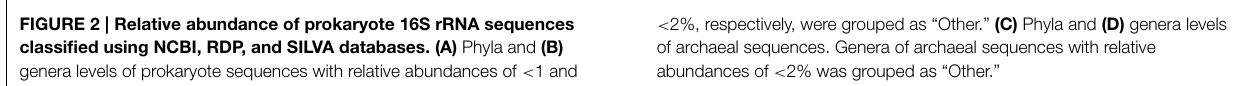
< 2%, respectively, were grouped as “Other.” (C) Phyla and (D) genera levels of archaeal sequences. Genera of archaeal sequences with relative abundances of < 2% was grouped as